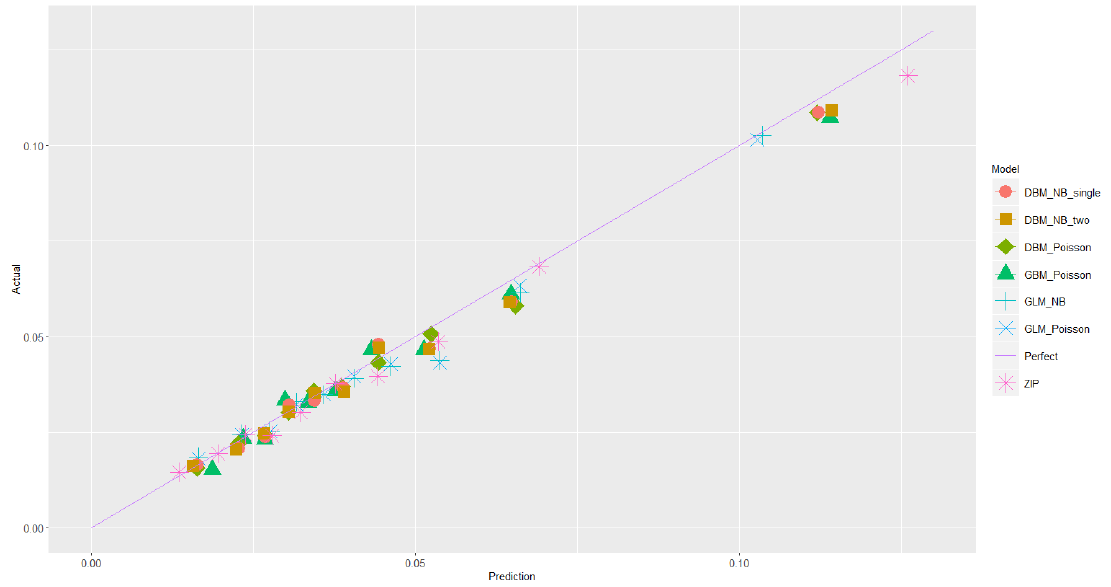
Figure 1. Lift plot for regression models.